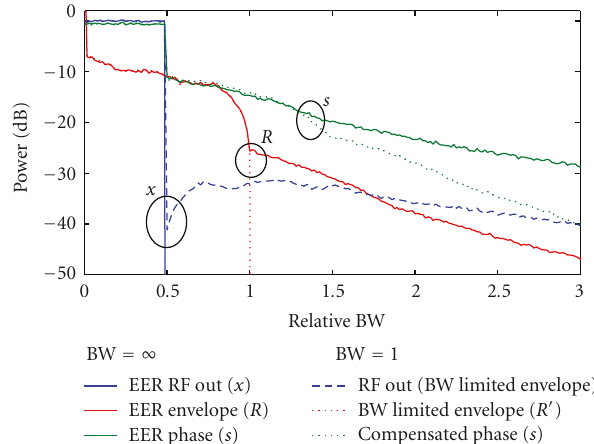
Figure 10: Spectra of the input drive signal, s , envelope signal, R , and RF signal, x .